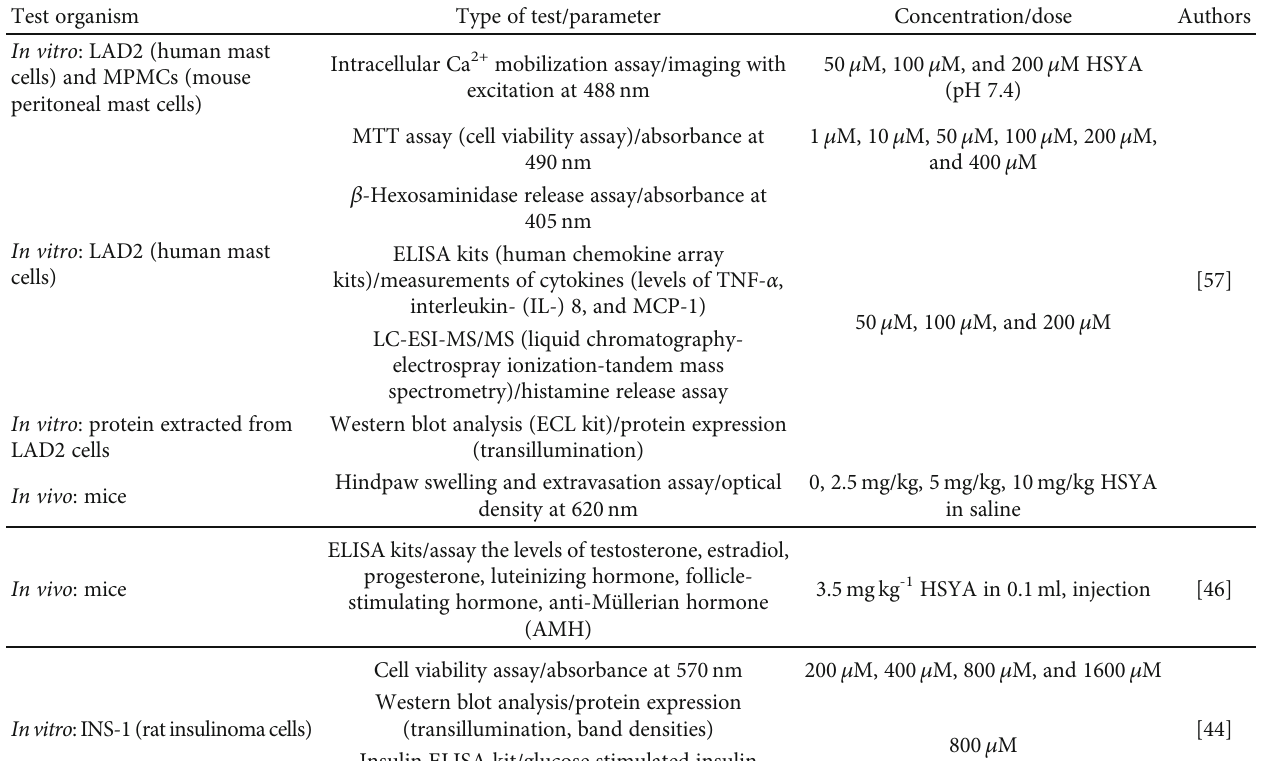
[44]Western blot analysis/protein expression (transillumination, band